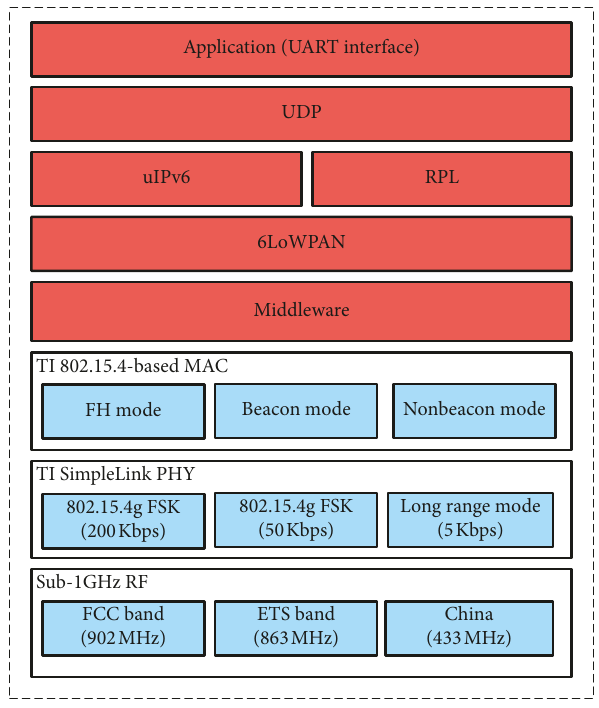
Figure 1: FH-based 6LoWPAN mesh system